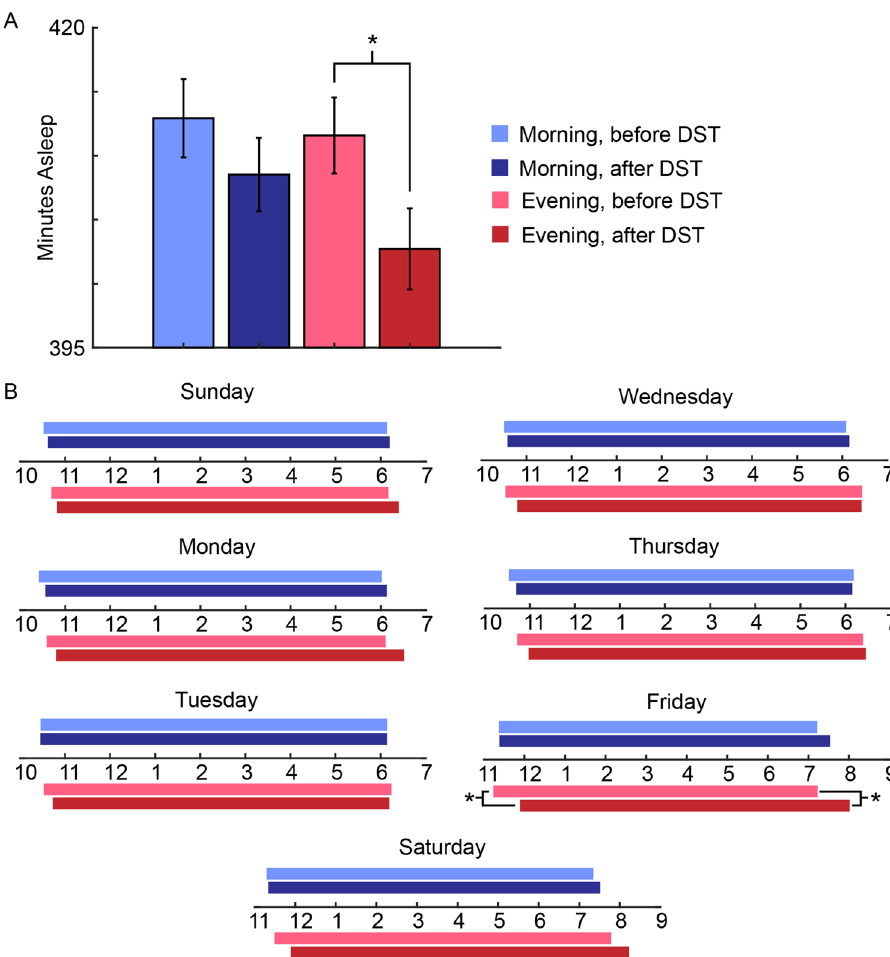
Figure 2. Analysis of Sleep Events before and after DST starts. ( A ) The mean asleep time on work nights (i.e., Sunday-Thursday nights) for the morning population is consistent across the week before DST (412.9 ± 3 min, n = 676 sleep events) and the week after DST (408.5 ± 2.9 min, n = 671 sleep events). The mean asleep time on work nights for the evening population decreases from 411.6 ± 2.97 min (n = 651 sleep events) to 402.7 ± 3.16 min the week after DST (n = 602 sleep events, T-statistic = − 2.0451, P = 0.041). ( B ) Mean sleep profiles of the morning (blue) and evening (red) populations for the night of the week before (lighter shade) and after DST (darker shade). For statistical analysis on circular data, we use the Parametric Watson-Williams multisample test for equal means (F-statistic = 5.11 and P = 0.025 for sleep onset and F-statistic = 6.73 and P = 0.0102 for sleep offset). See Table 1 for the sample sizes in each